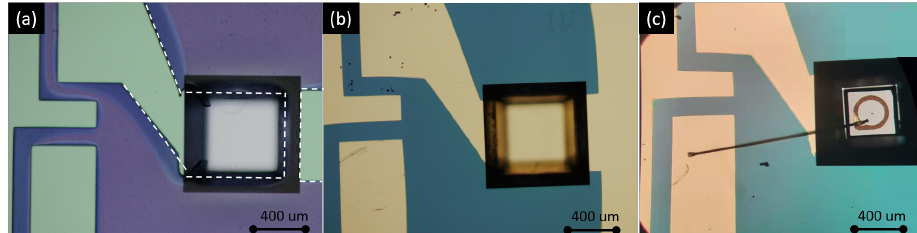
Figure 6. ( a ) Patterned photoresist film (in purple) at the input side, the resist film is hanging over the edge of the trench. ( b ) Contact pads after gold deposition and lift-off. ( c ) Bonded LED chip in the trench, with a wire bond connecting the top contact of the LED and the contact pad on the substrate.